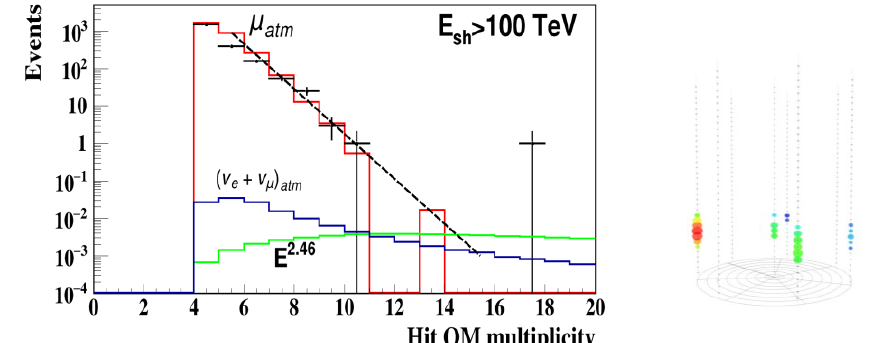
Fig. 1. Left: Multiplicity distribution of hit OMs for experimental events with reconstructed energy E rec > 100 TeV (dots). Also shown are the distributions of expected events from astrophysical neutrinos with an E -2.46 spectrum and of background events from atmospheric muons and neutrinos. Right: The event with a hit multiplicity of 17 was observed on October 2015.